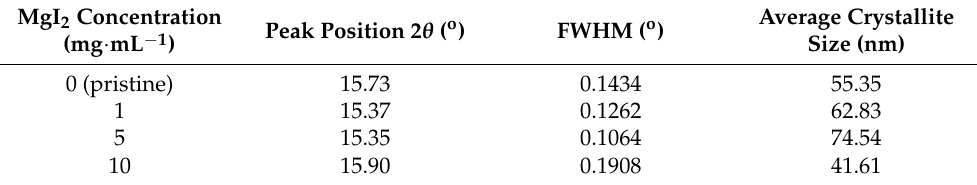
Table 1. Crystallite size calculation for perovskite thin films with different concentrations of MgI 2 .